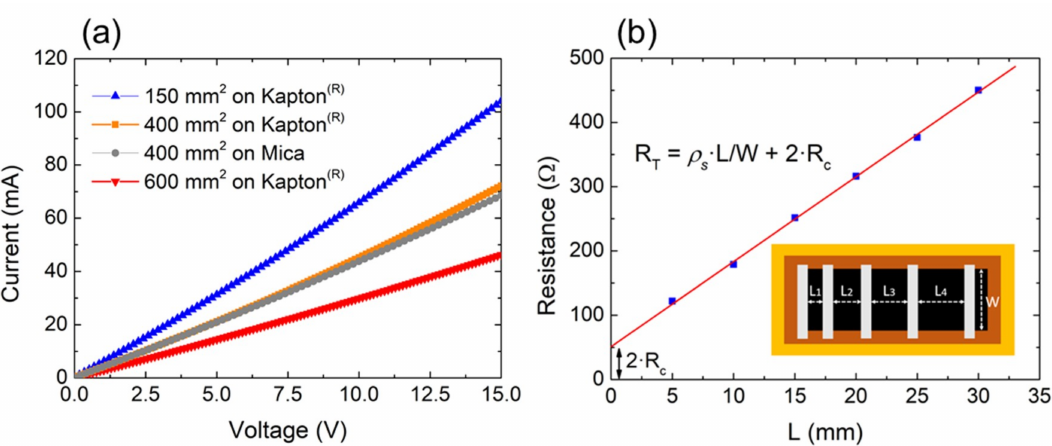
Figure 2. ( a ) Current–voltage (I–V) curves for di ff erent LrGO films on flexible substrates: 150 mm 2 (L = 10 mm, W = 15 mm), 400 mm 2 (L = 20 mm, W = 20 mm), 600 mm 2 (L = 30 mm, W = 20 mm). ( b )Total resistance (R T )as afunction ofthedistance betweenconsecutive contacts (L i )and itsrelationship with sheet resistance ( ρ s ), contact resistance (R c ), and dimensions (L,